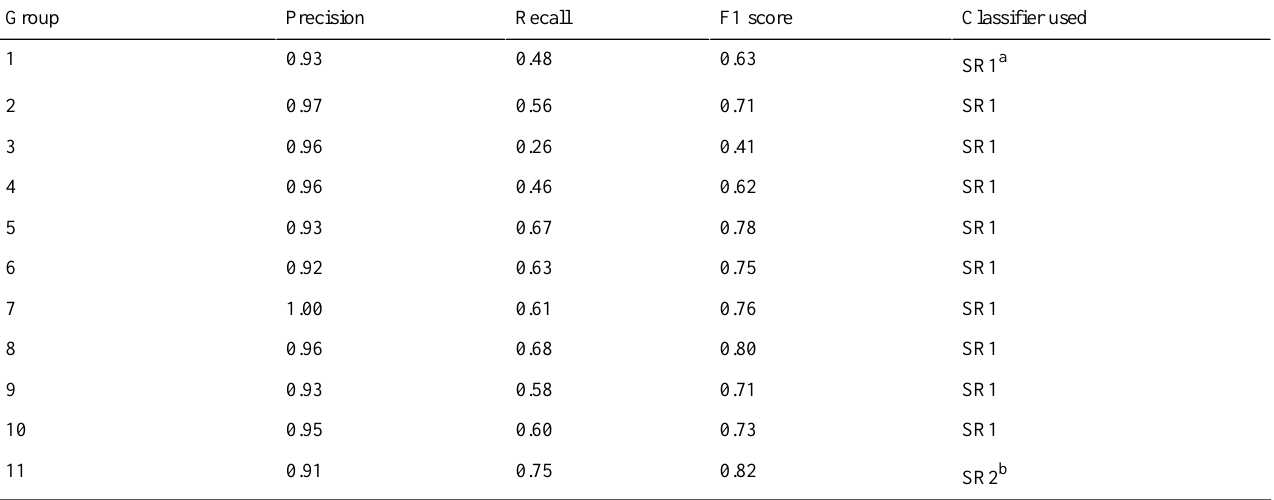
Table 5. Precision, recall, and F1 score of the chatbot’s pro and con